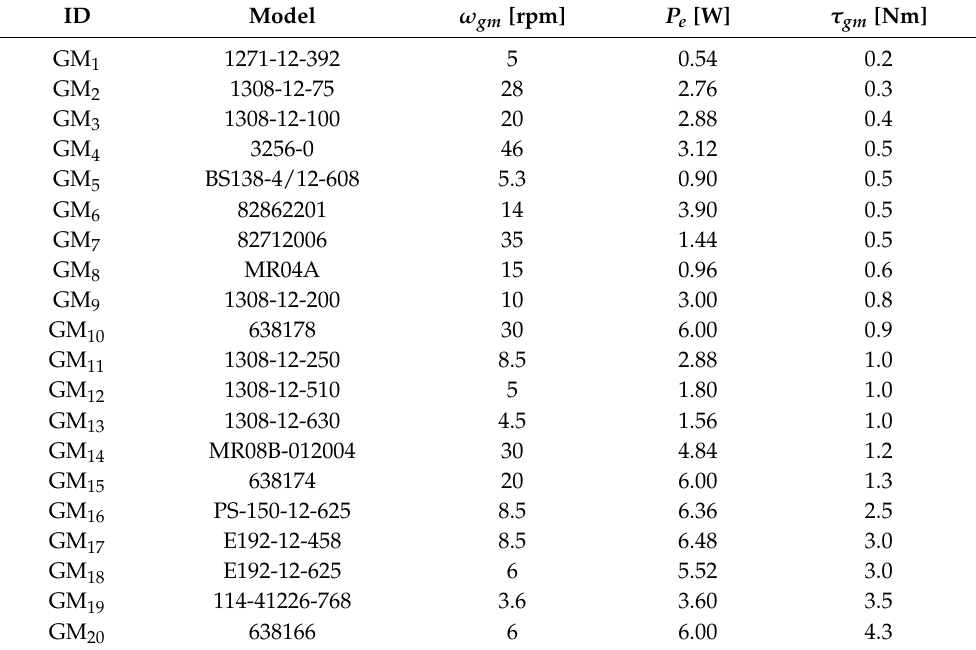
Table 2. Parameters of pre-selected geared DC